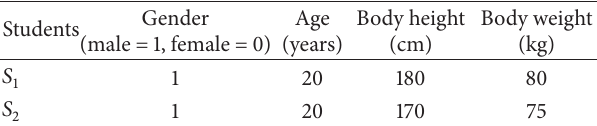
Table 1: Four features of students 𝑆 1 and 𝑆 2